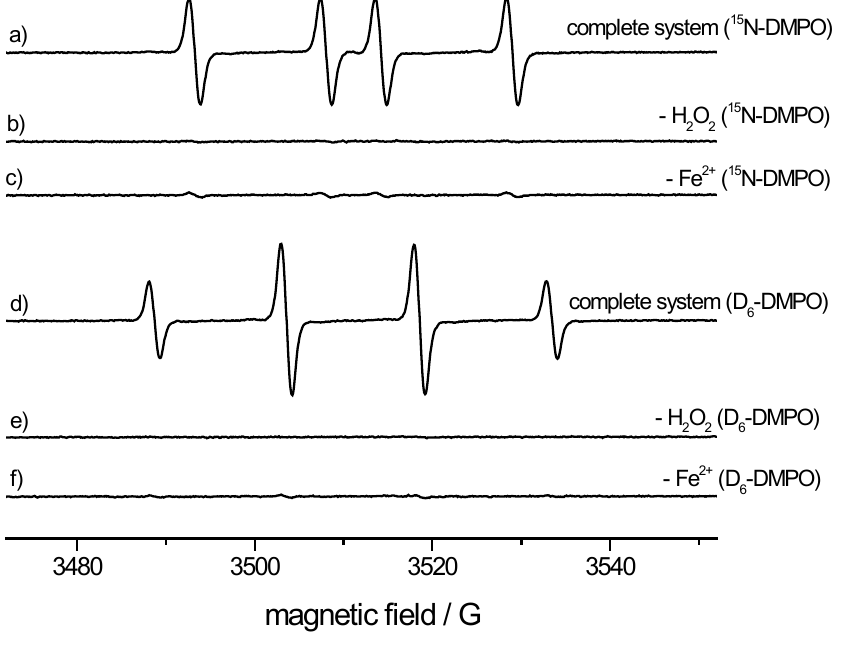
, 200 μM H O in 4 2 2